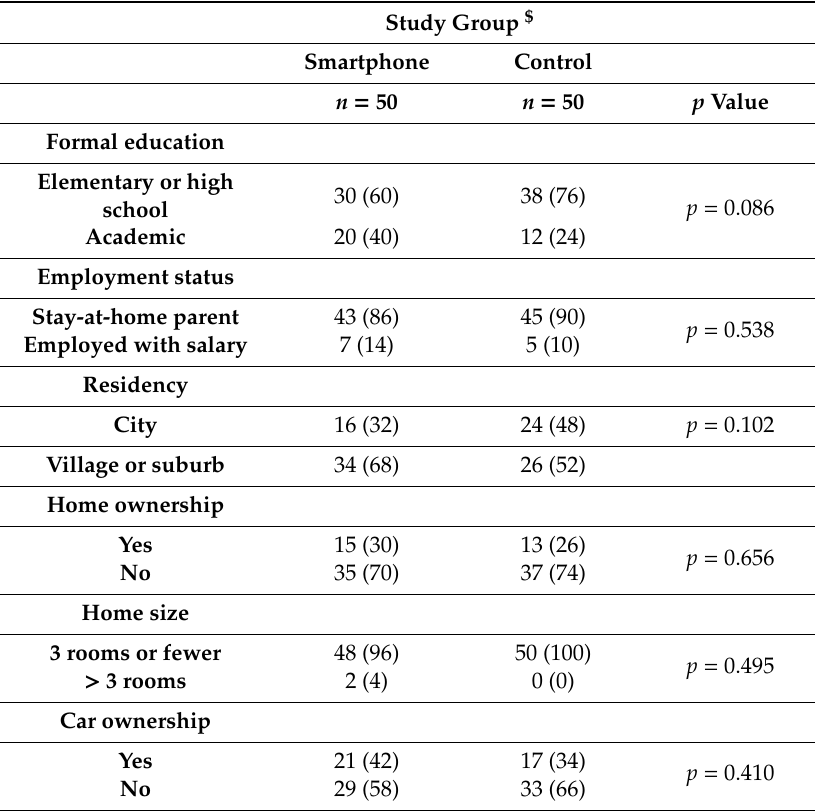
Table 1. Characteristics of participating mothers ( n (%)).